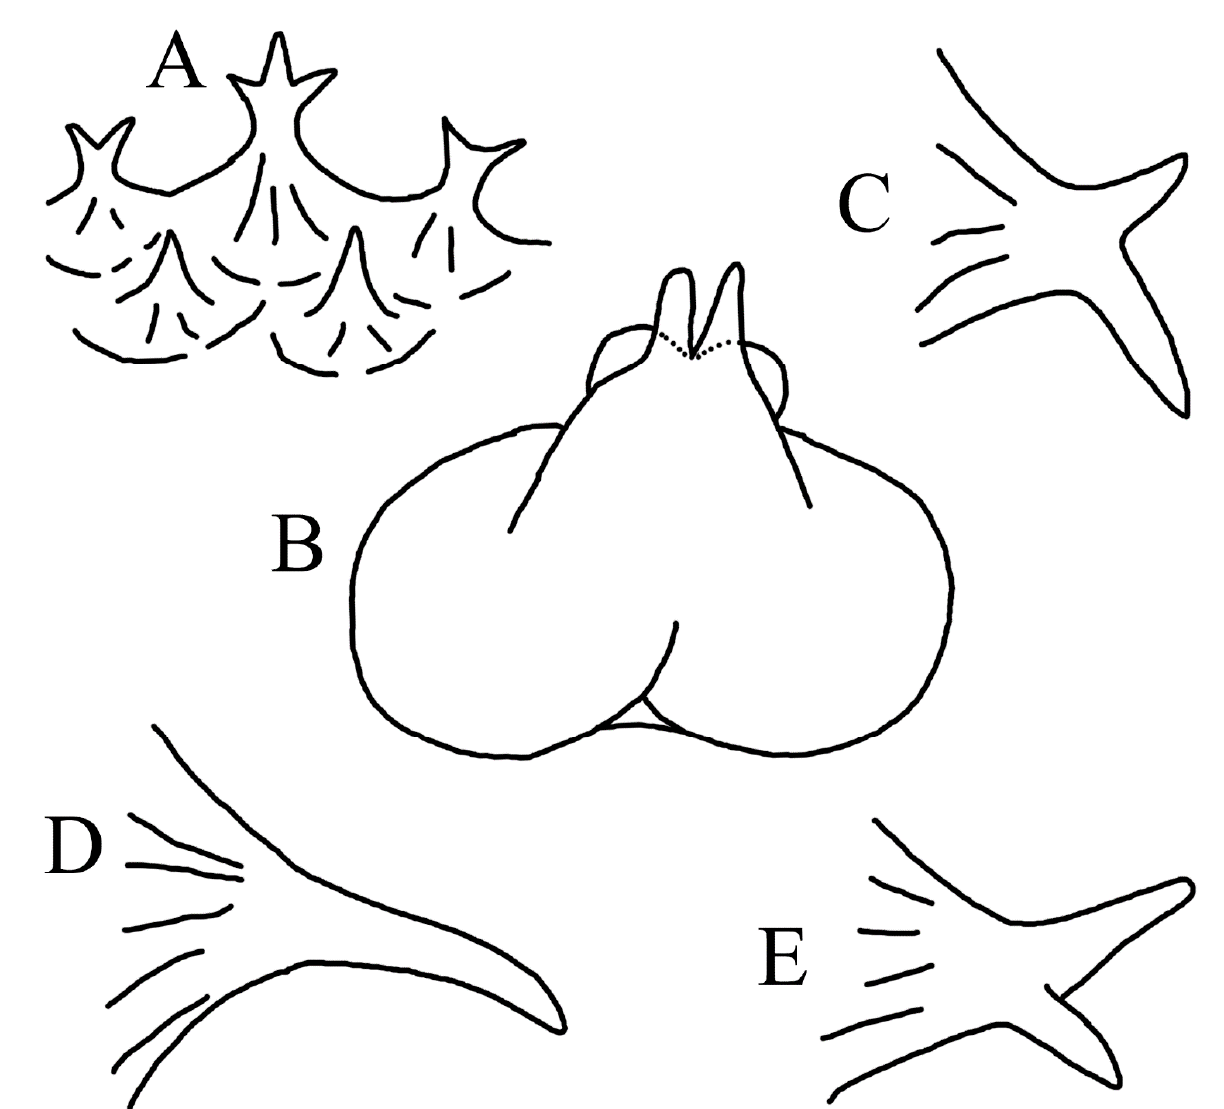
Figure 28. Esca and squamation of H. oblonga (Smith and Radcliffe, 1912), FRIP 0516, 58.0 mm SL. ( A ). Rostral tubercles. ( B ). Esca. ( C ). Tubercle on disk margin. ( D ). Tubercle on tail. ( E ). Subopercular tubercle.